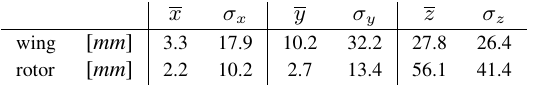
Table 2: The mean and standard deviation of the re-projection error of control points in millimeters over three dimensions for the two datasets, using a population of 16 and 12,